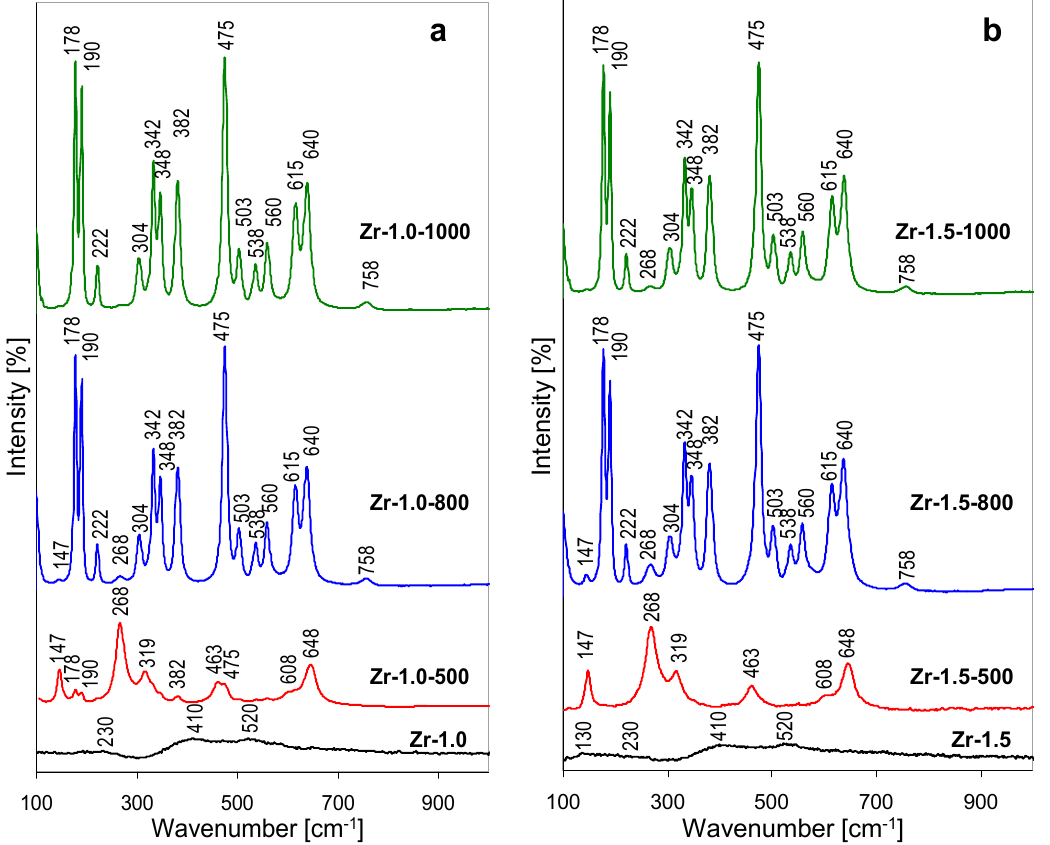
Figure 5. Raman spectra illustrating the effect of thermal treatment on hydrolysates obtained by lyophilization of Zr-pillaring solution: ( a ) As received at pH = 1.0, ( b ) after pH adjustment to 1.5. SEM images of samples Zr-0.1-1000 and Zr-1.2-1000, presented in Figure 3b,e, respectively, show that in both materials’ zirconia grains consist of variously shaped agglomerates.